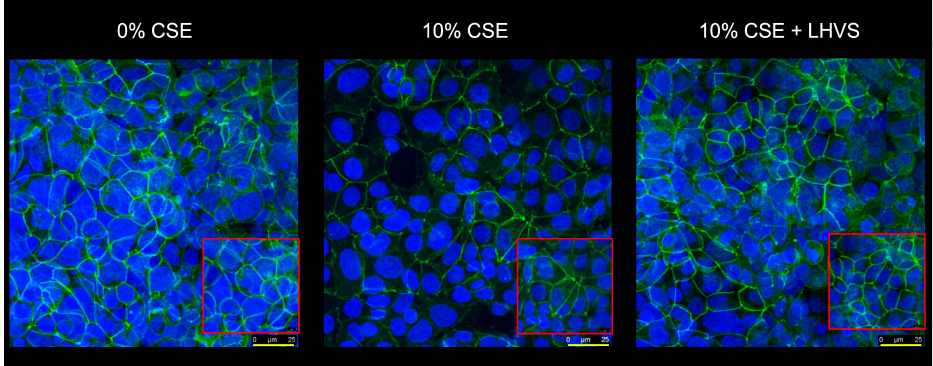
Figure 9. Occludin is a proteolytic target of CSE-induced CatS within tight junctions of lung epithelial cells. As described earlier, 16HBE cells (upper culture chamber) were co-cultured with THP-1 cells (lower culture chamber), which were exposed to CSE (0–10%) for 12 h. LHVS (100 nM) was used as control. After incubation, 16HBE cells were treated with an anti-occludin antibody, as described earlier. Images were acquired in z-stack, with the first and last planes of focus corresponding to a thickness of 1 cell. Representative confocal microscopy images from z-stacks overlaid with Hoechst 33342 (nuclear stain) of three independent experiments are shown. Scale bar: 25 µm (in yellow). The inserted area (framed: red color) corresponds to an original acquisition zoom (scale bar: 8 µm).